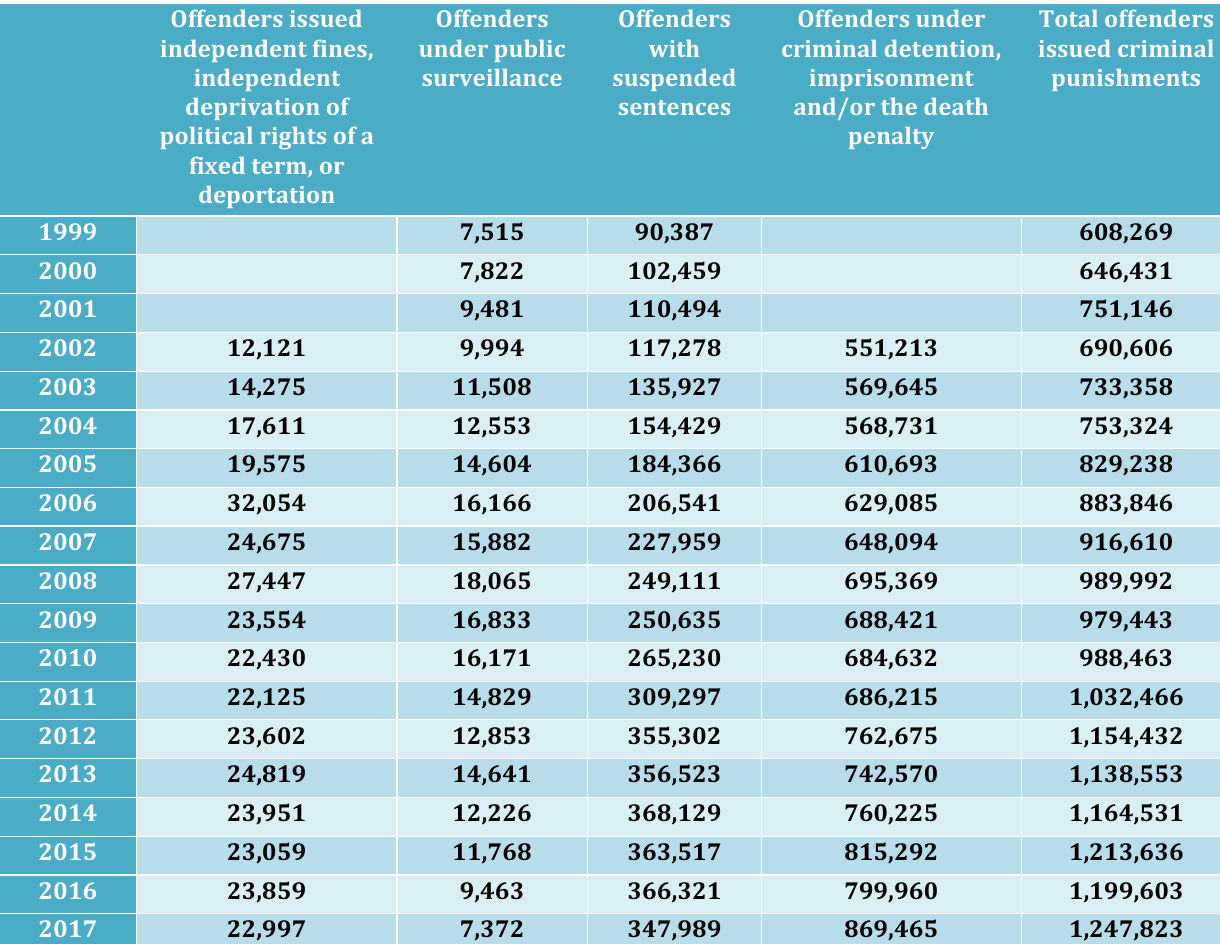
Table 1: Number of different punishments in criminal sentences nationwide, 1999 –